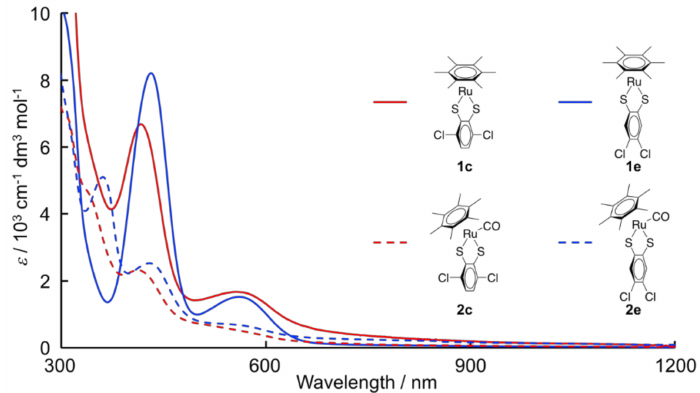
Figure 3. UV-Vis-NIR spectra of 1c , 1e , 2c , and 2e in